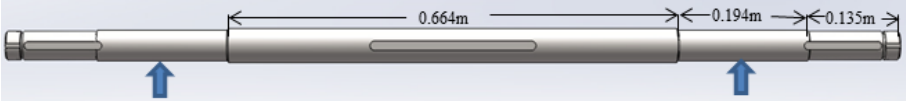
Figure 5. Three-dimensional structure and parameters of main shaft.